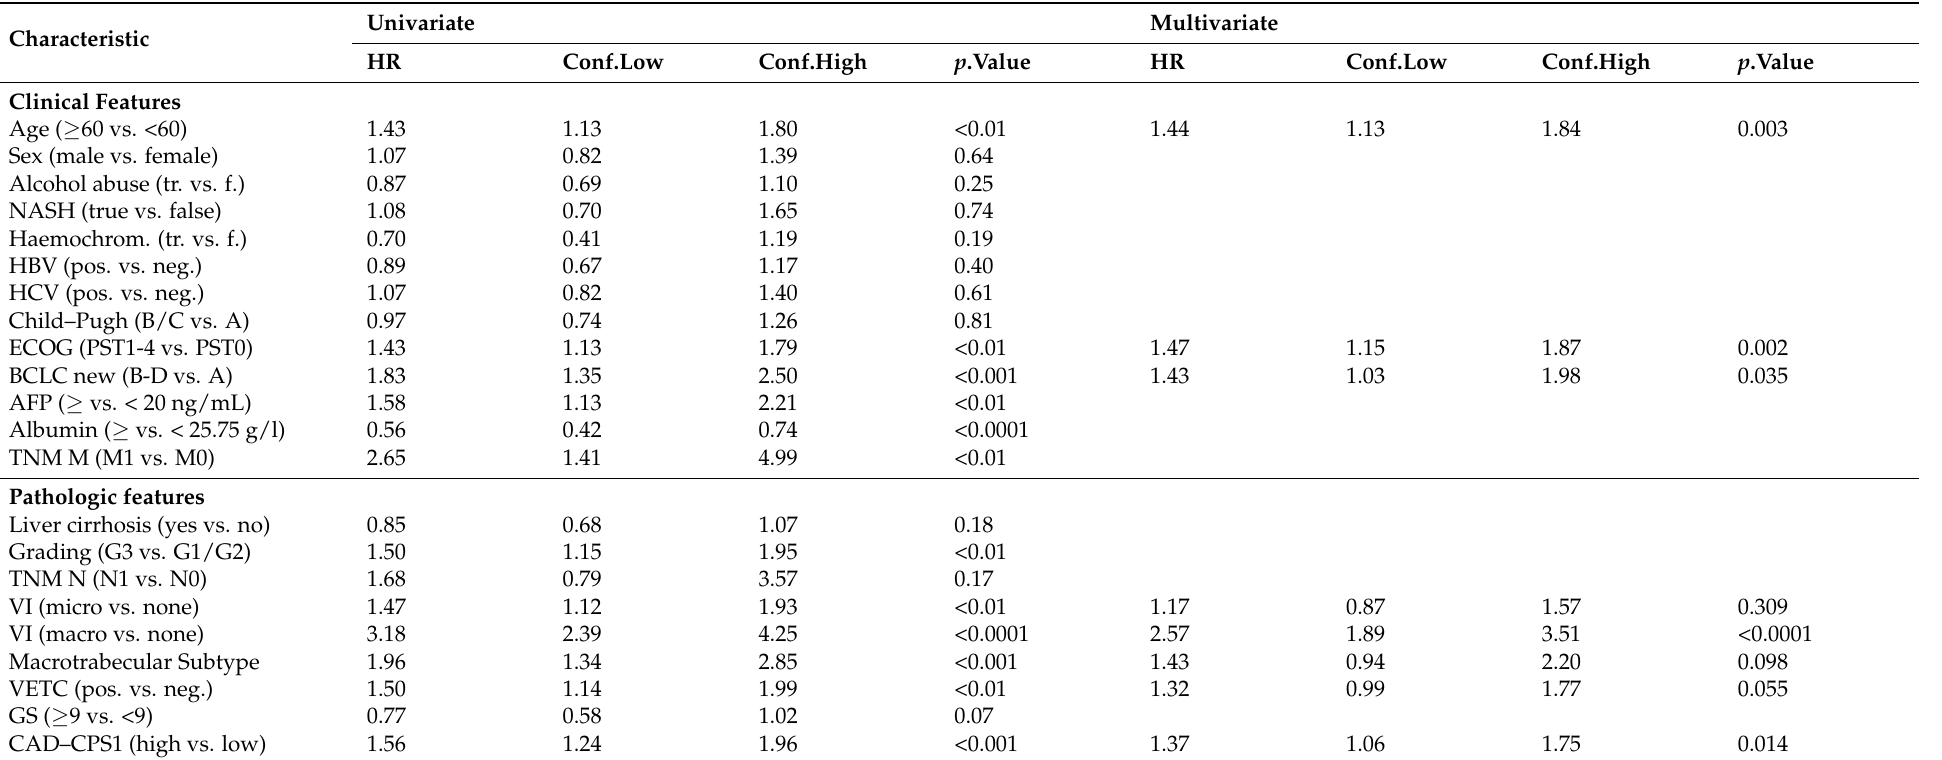
Table 3. Univariate and multivariate Cox regression analyses of prognostic factors (overall